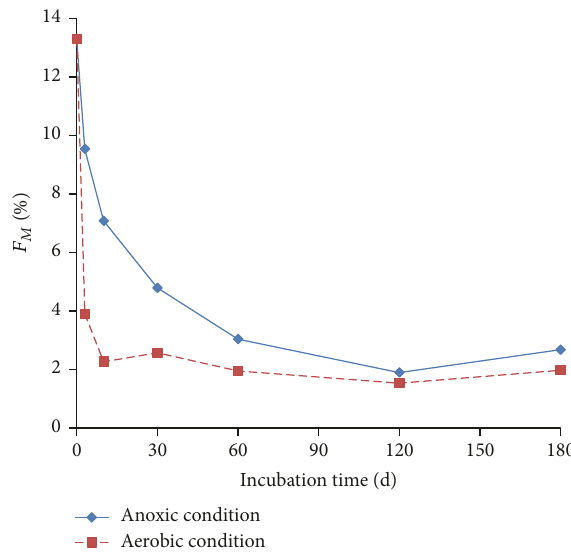
Figure 4: Changes of As bioaccessibility in soils under different redox conditions after the addition of iron grit over time (anoxic condition, S IN ; aerobic condition, S IA